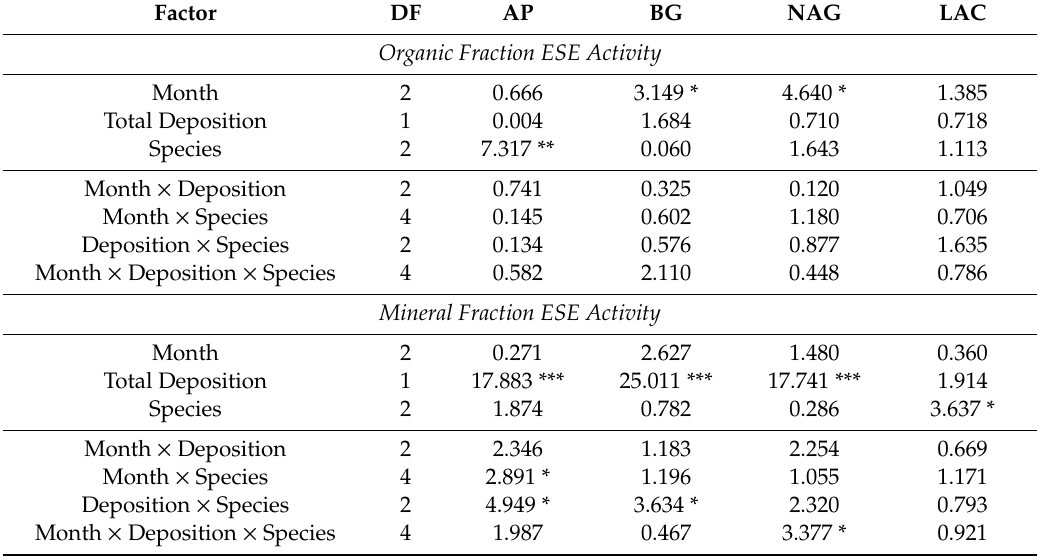
Table 1. F-statistics for three-way ANOVA tests for soil extracellular soil enzymes (ESE) activities.